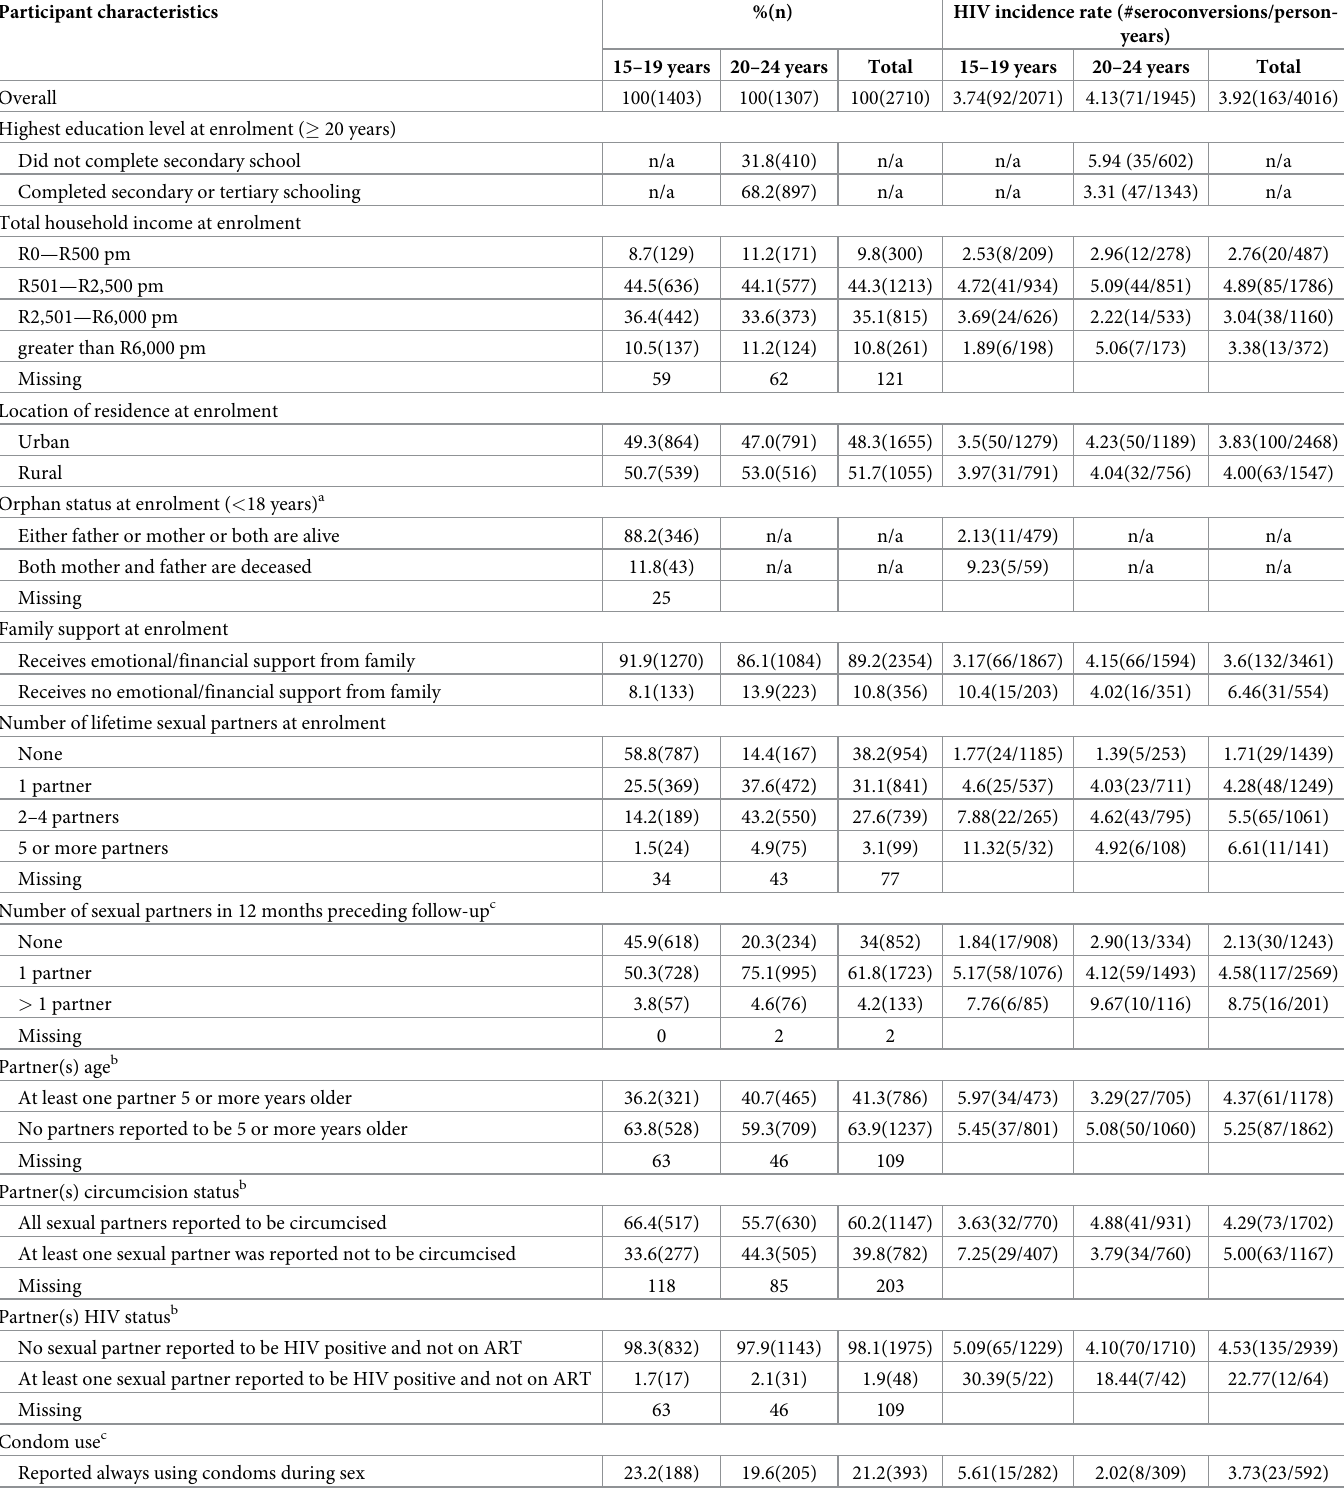
Table 1. Baseline and follow-up characteristics and HIV incidence in adolescent girls and young women enrolled in the HIPSS cohort. Participant